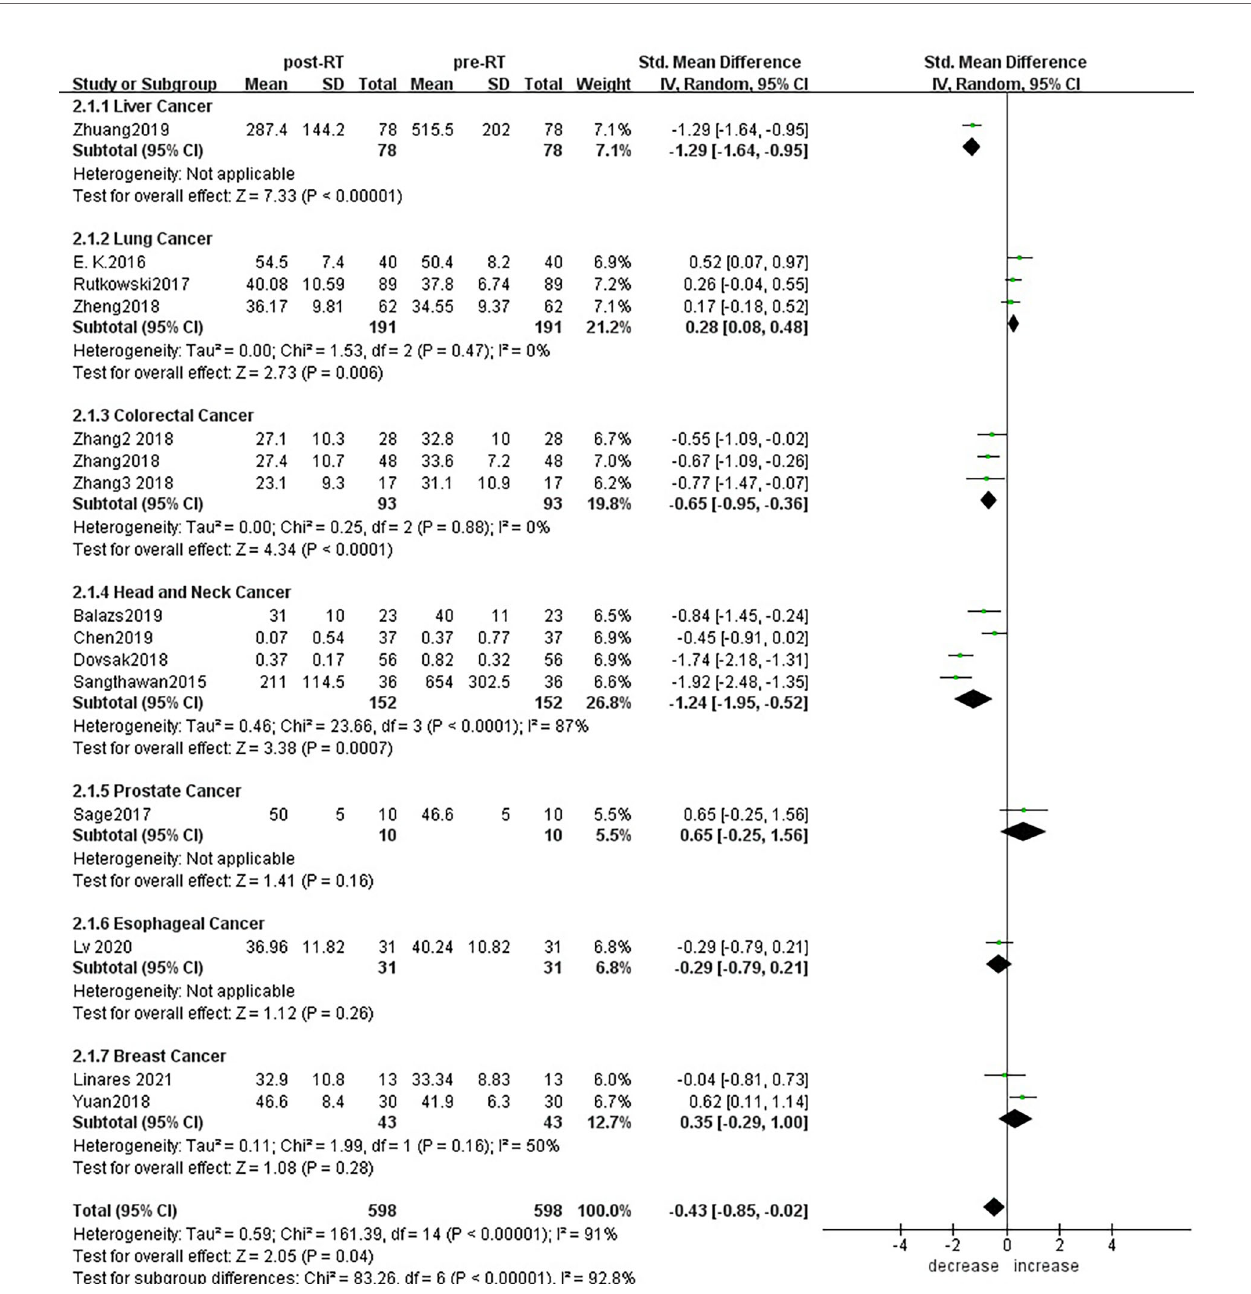
FIGURE 8 | Forest plots of subgroup analysis for changes of CD4+ T lymphocyte after radiotherapy compared with before radiotherapy in different